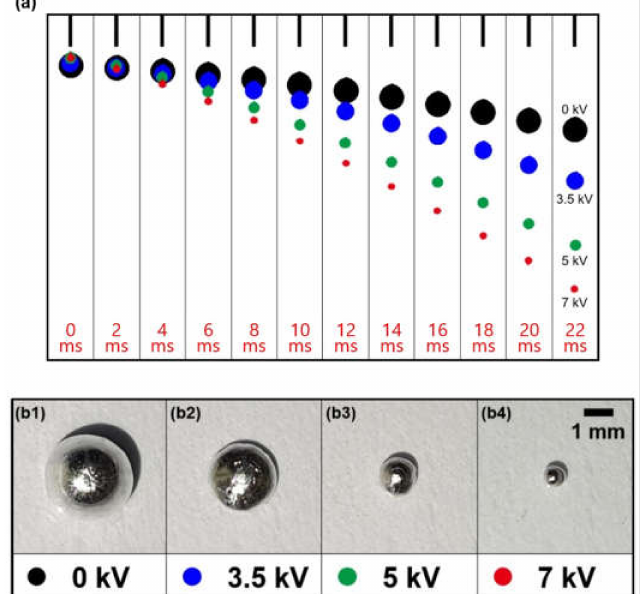
Figure 3. ( a ) Superimposed sequences of the falling gallium-based liquid metal droplet and ( b ) optical images of dropped liquid metal droplet, generated by the electro-hydrodynamic method with various applied voltages of ( b1 ) 0, ( b2 ) 3.5, ( b3 ) 5, and ( b4 ) 7 kV between a needle and circular-shaped Cu electrode (multimedia